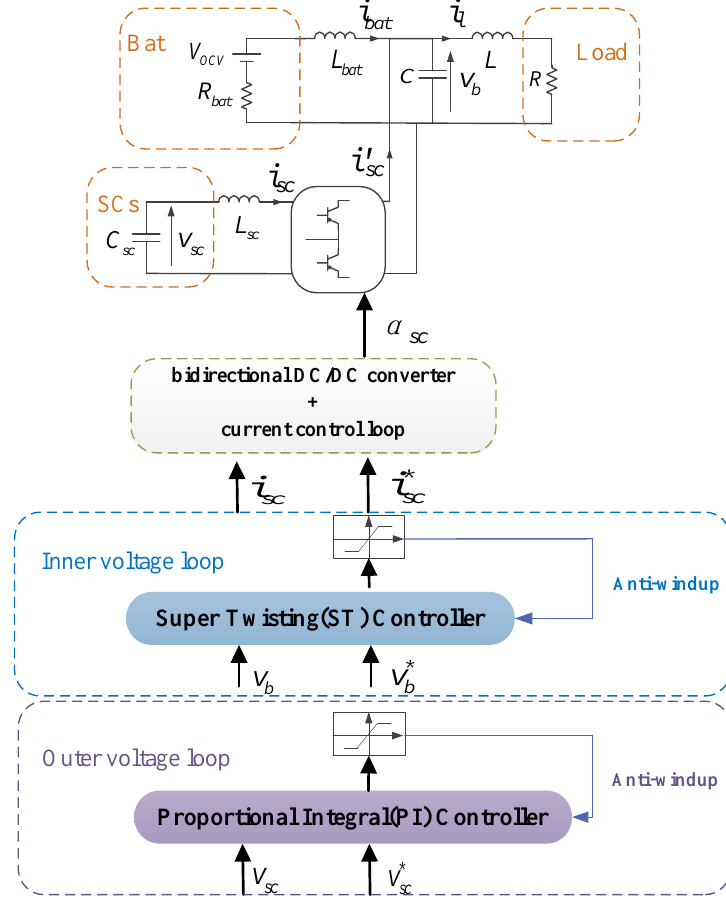
Figure 3. System topology and control